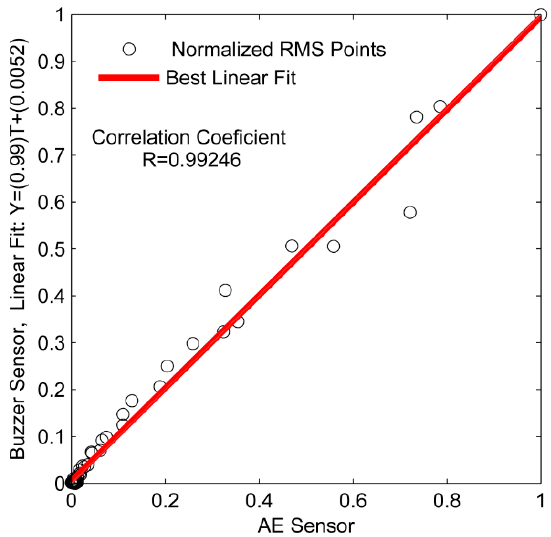
Figure 13. Linear fit and correlation coefficient for RMS signals.